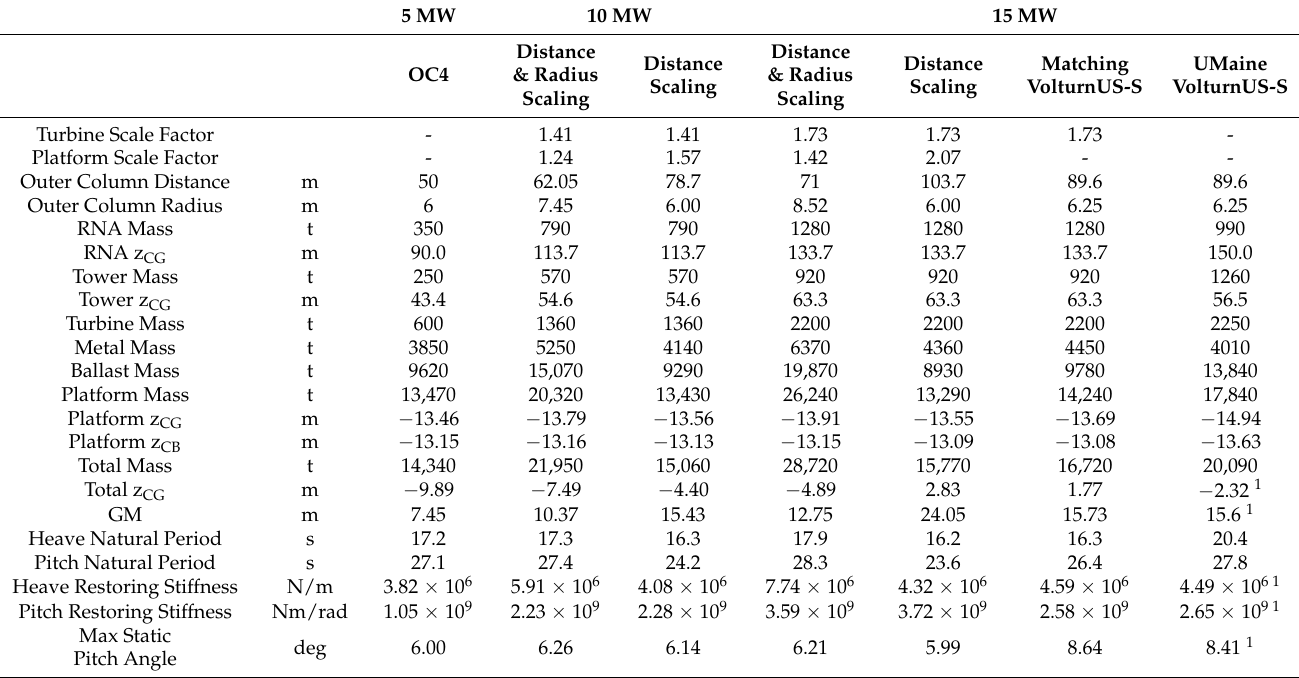
Table 3. Reference and upscaled